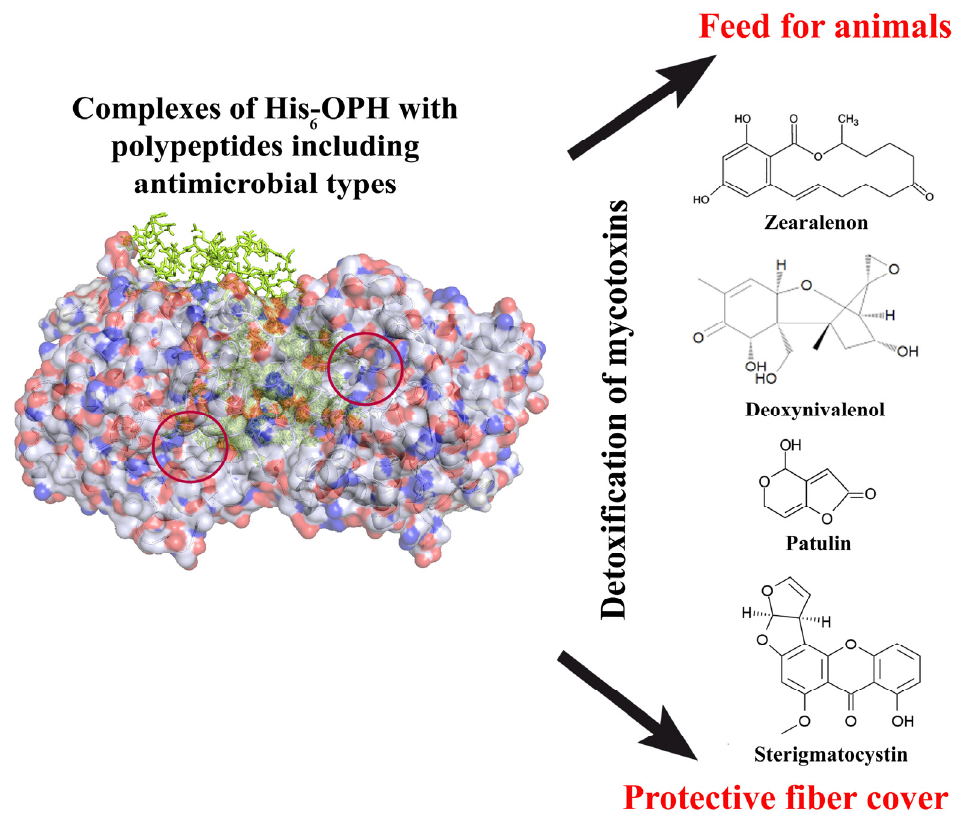
Figure 2. Application of His 6 -OPH in the content of EPC for the degradation of some mycotoxins in the content of animal feed and in the frame of protective fiber cover.